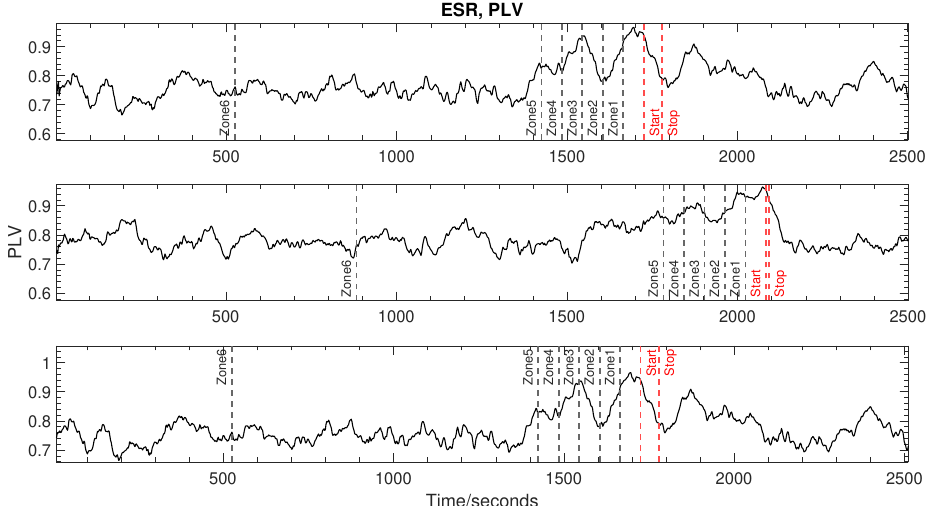
Figure 6. This figure shows the the PLV results of signal 2 from 3 separate patients, all with a clinically diagnosed seizure. The zones are pre-ictal definition sections, as explained in Section